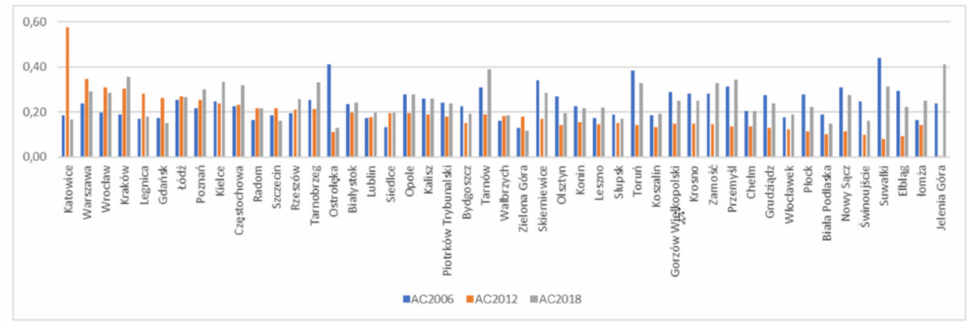
Figure 24. The AC index in the analysed cities in Poland. Source: own